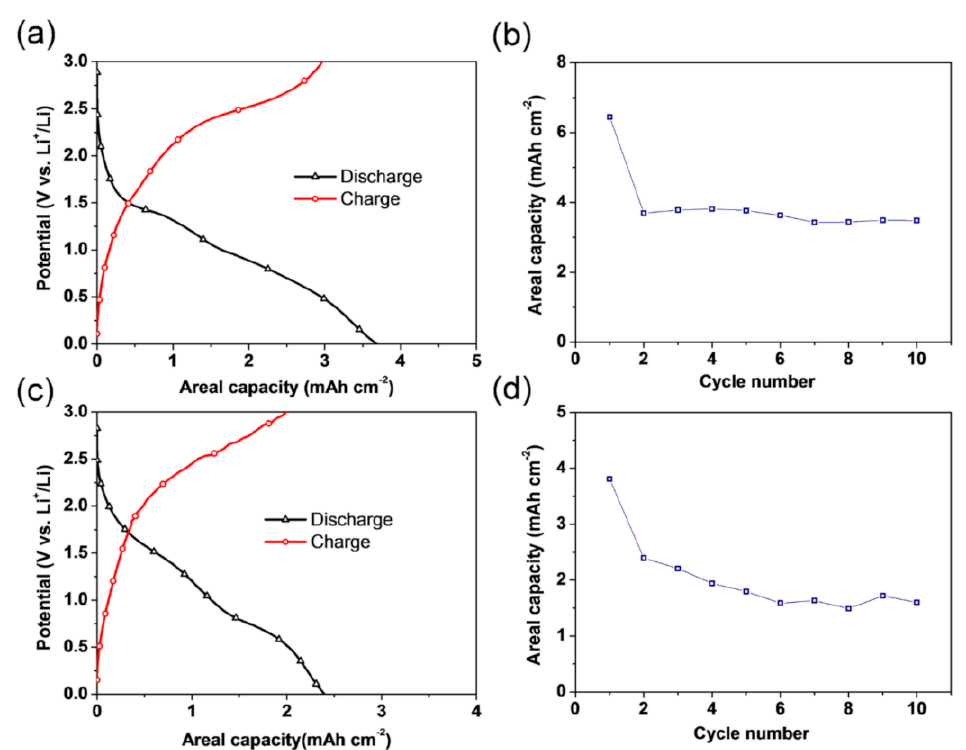
Figure 12. Voltage profiles of Cu foams oxidized at ( a ) 170 ◦ C and ( c ) 200 ◦ C, as well as a comparison of the areal capacity of Cu foam anodes that were oxidized at ( b ) 170 ◦ C and ( d ) 200 ◦ C at 1 mA/cm 2 in 0.01–3.0